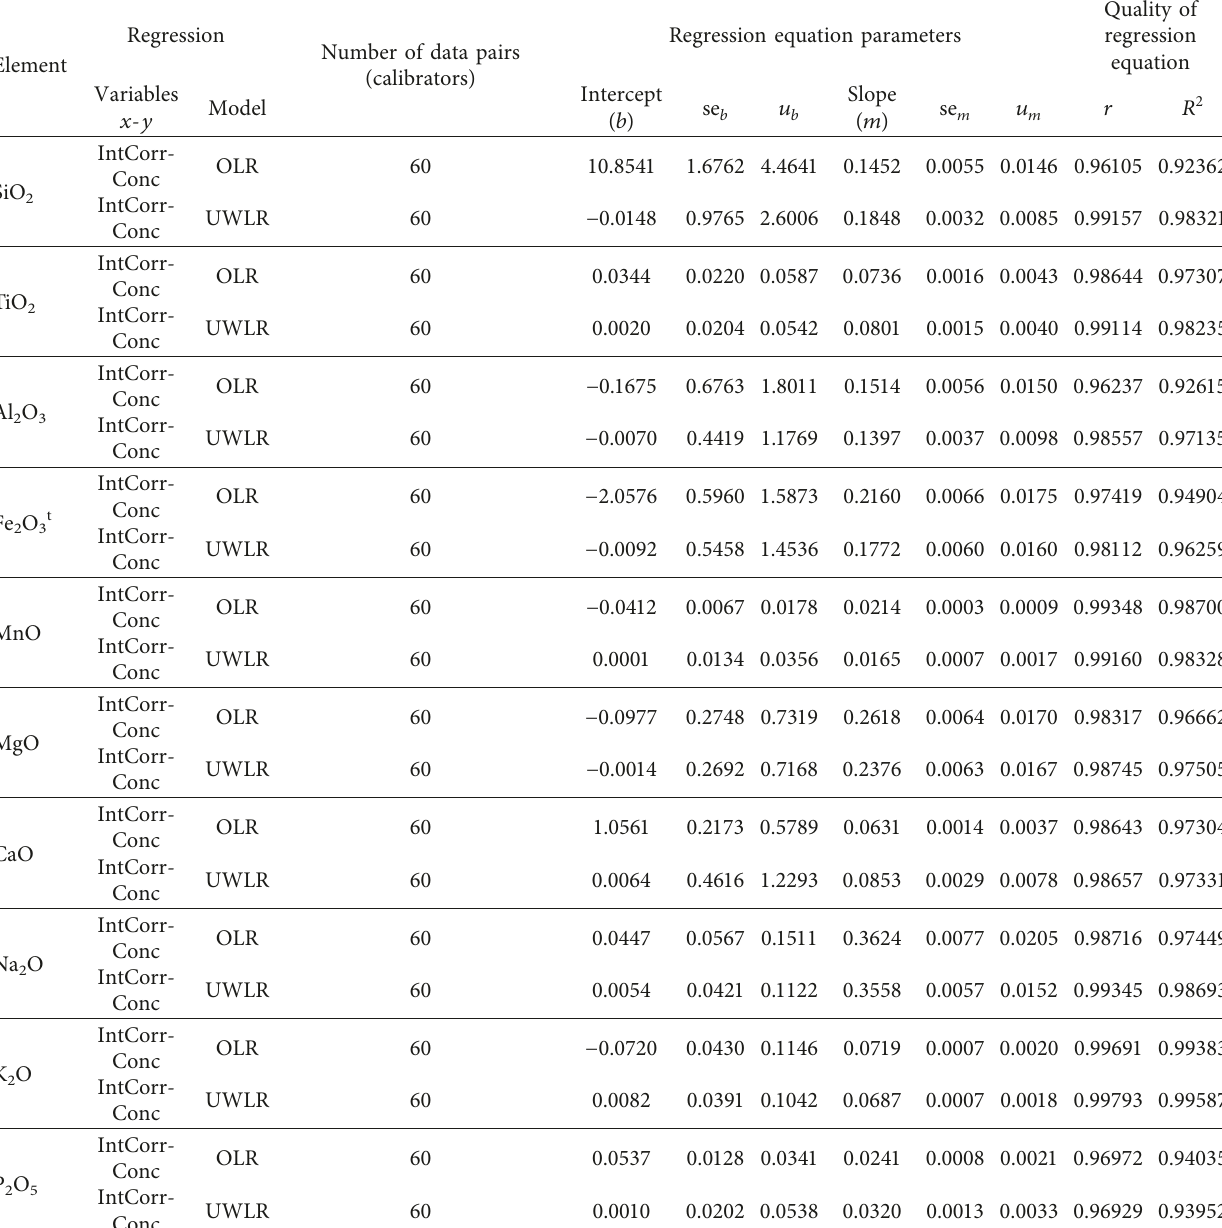
Table 2: Regression ( x - y ): matrix-corrected intensity-concentration (IntCorr-Conc)